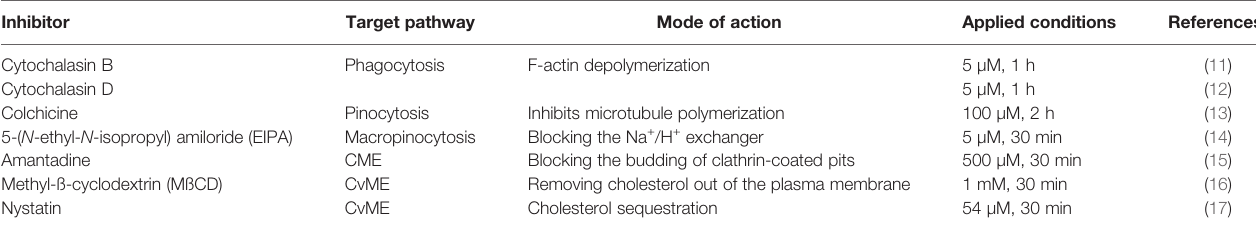
TABLE 1 | List of the pharmacological inhibitors and their applied conditions in the endocytosis experiments.